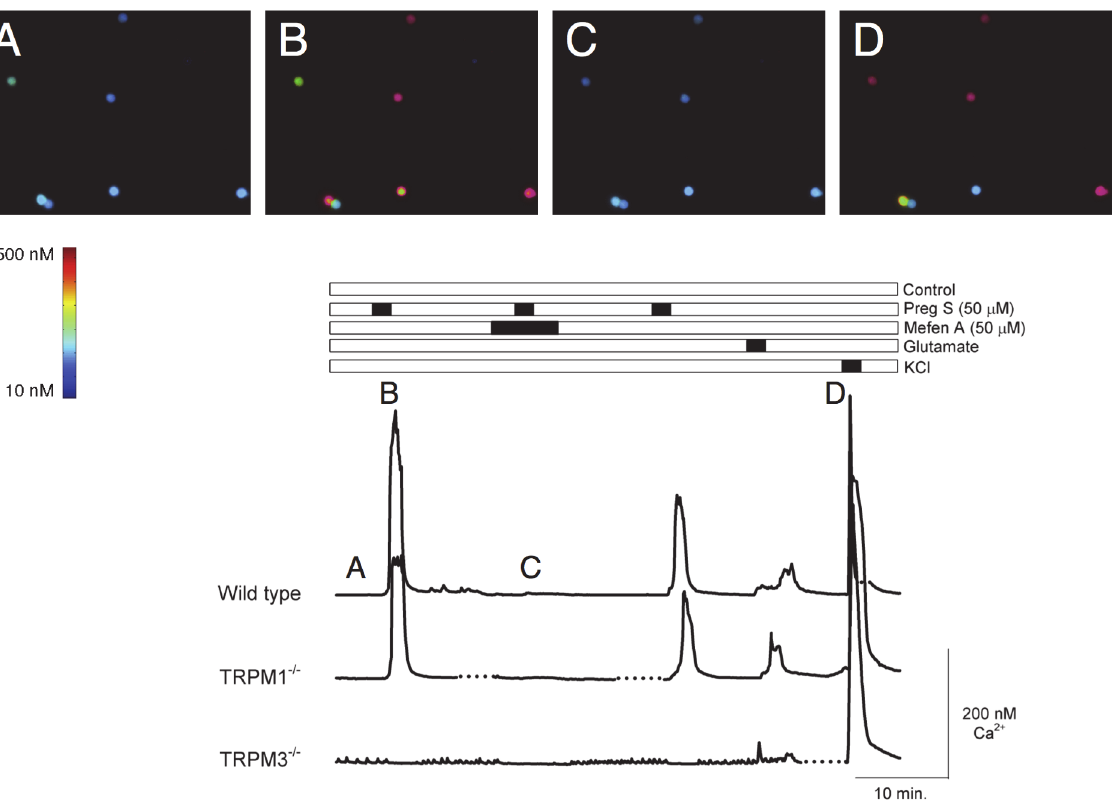
Fig 5. TRPM3-dependent intracellular calcium increases in mouse retinal ganglion cells. Ca 2+ signals were recorded from immunopanned ganglion cells by Fura-2-based ratiometric imaging. Dotted lines indicate where gaps were introduced in some traces to facilitate proper alignment. Greater than 50% of ganglion cells from WT mice responded to Pregnenolone Sulfate (PS)-activated rises in calcium ( B ) compared to baseline ( A ); the PS signal was abolished by pretreatment with mefenamic acid (MA; C ). In the TRPM3 -/- mice, no cells produced a large response to PS; a few cells, however, gave a small response that was not blocked by MA. At the end of the experiment, cells were depolarized with KCl perfusion to verify viability ( D